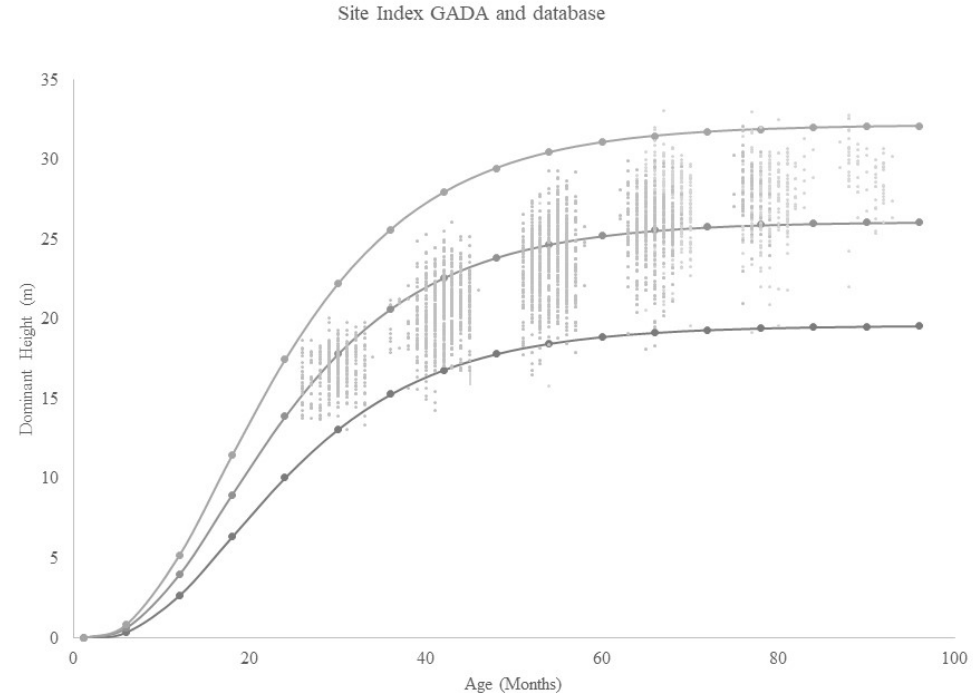
Figure 4. Site index for stands of Eucalyptus sp. in a tropical region of Brazil.